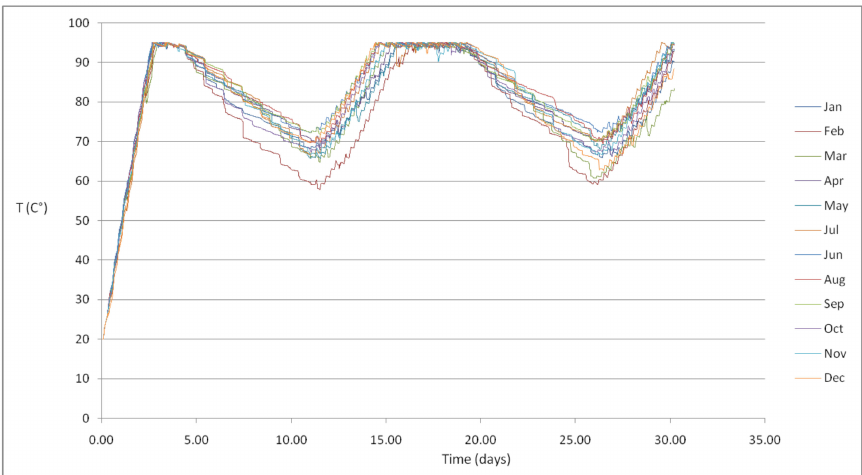
Figure 11. The temperature in the 2 m 3 hot water tank (HWT) (Case